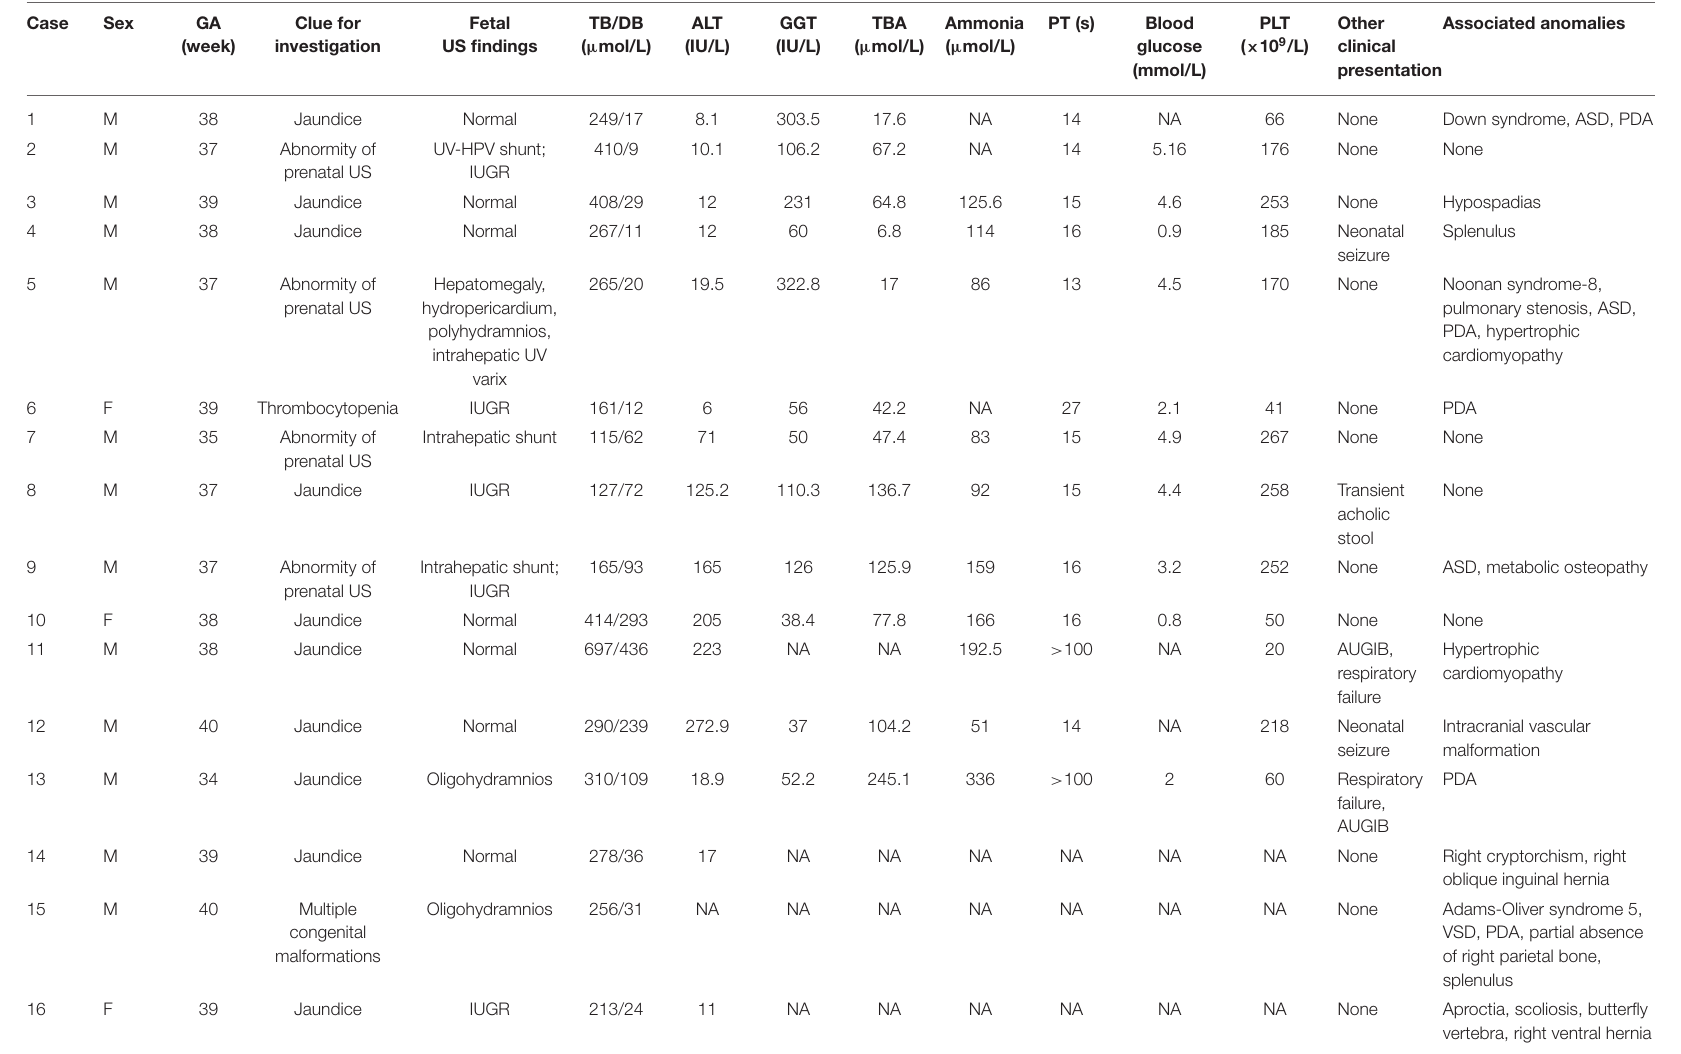
ALT, alanine aminotransferase; ASD, atrial septal defect; AUGIB, acute upper gastrointestinal bleeding; CPSS, congenital portosystemic shunts; DB, direct bilirubin; F, female; M, male; NA, not available; GA, gestational age; GGT, glutamyltranspeptidase; HPV, hepatic portal vein; IUGR, intrauterine growth restriction; PDA, patent ductus arteriosus; PLT, platelet count; PT, prothrombin time; TB, total bilirubin; US, ultrasonography; UV, umbilical vein; VSD, ventricle septal